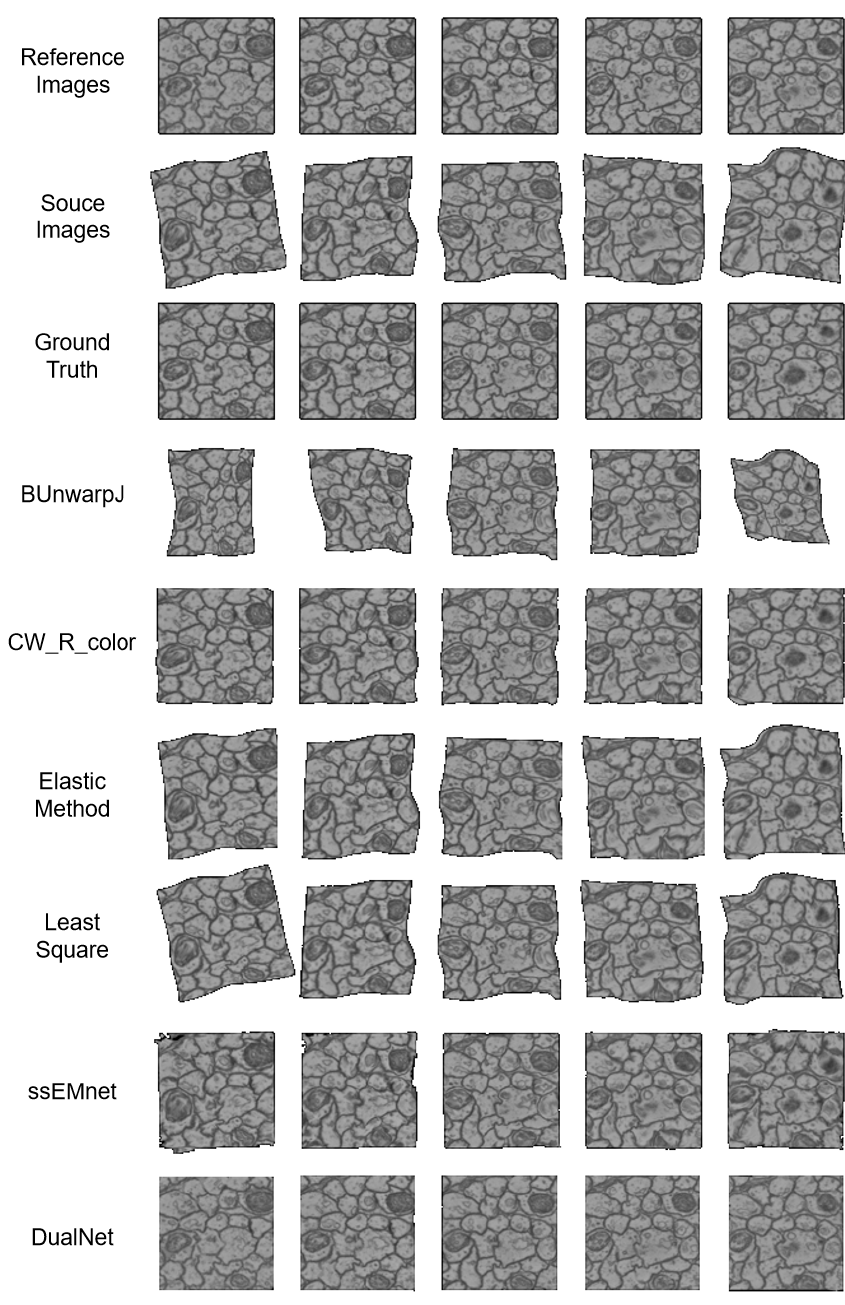
Figure 2. The registration results of baseline methods and our